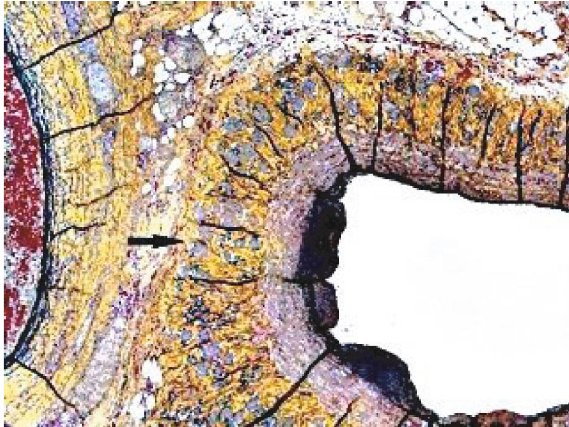
Figure 33: Vasospastic venous angiopathy. The arrow points to renal vein chie fl y thickened by fi brosis of the outer media and adventitia that surrounds surviving muscle cells — venous FMD. Movat stain × 50 (adapted from the World Journal Cardiovascular Diseases 2014.4, online publication).